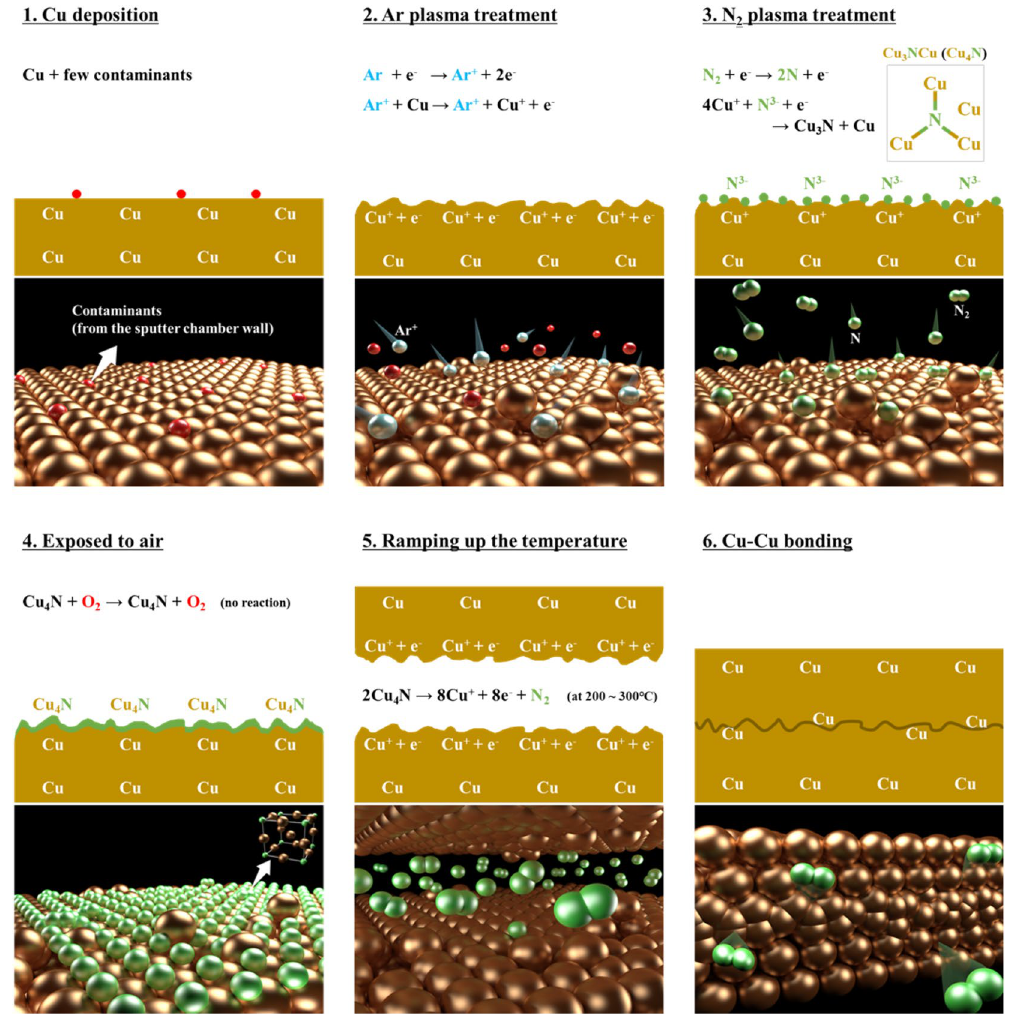
Figure 7. Low temperature Cu–Cu bonding mechanism using an anti-oxidant Cu layer by remote mode N 2 plasma in the two-step Ar/N 2 plasma process, including the formation and decomposition of Cu nitride